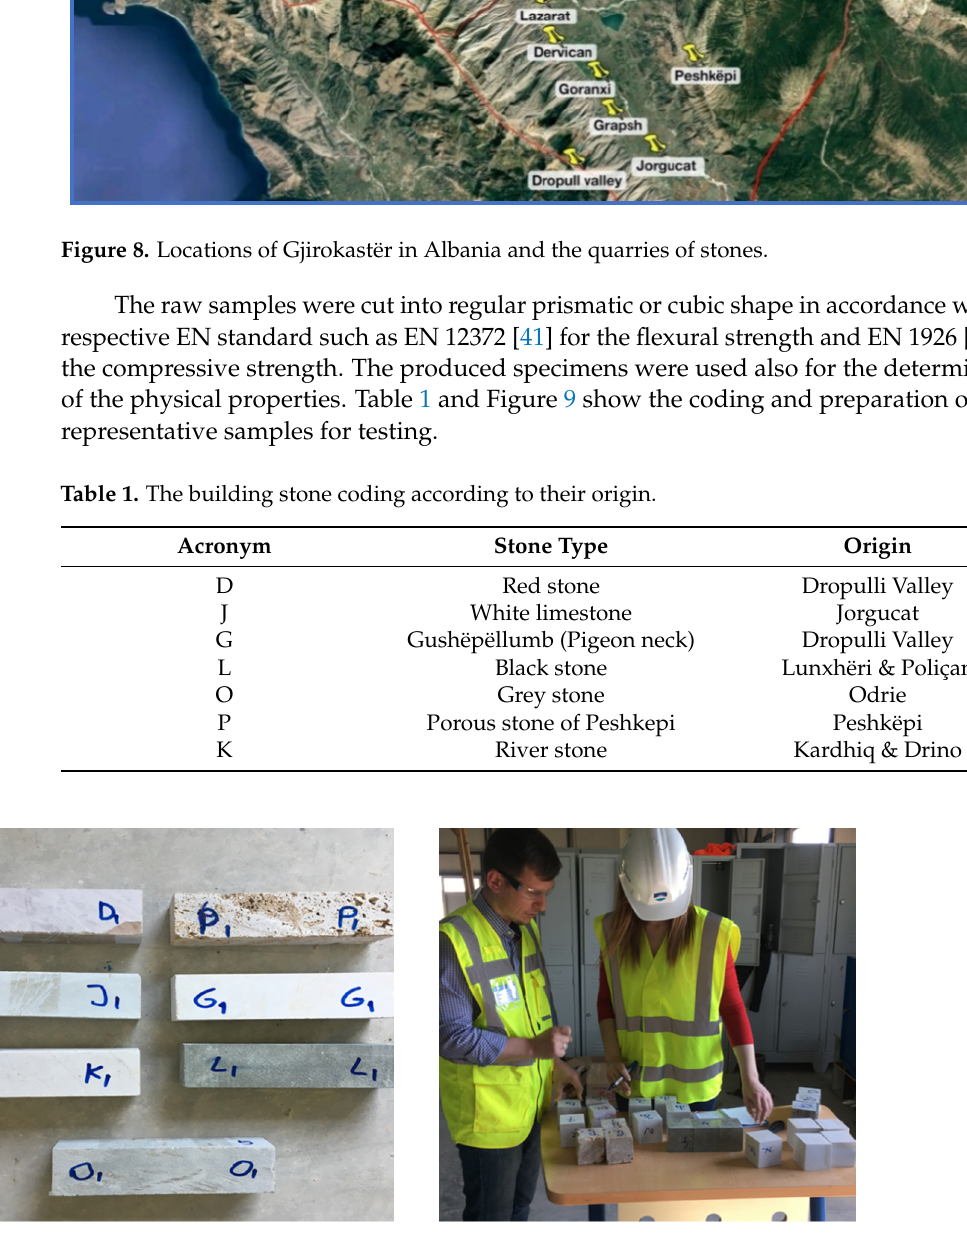
Figure 9. Representative stone prisms before testing.